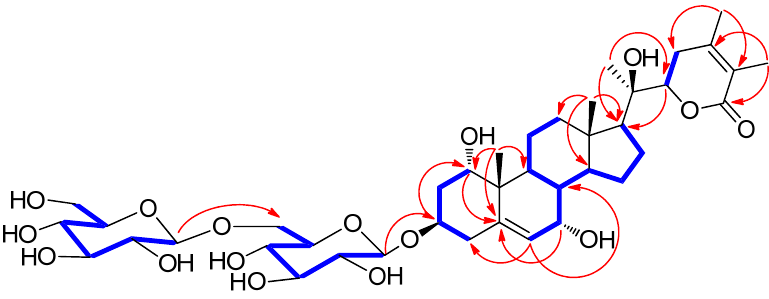
Figure 3. Key 1 H- 1 H COSY ( ) and HMBC ( ) correlations for 1 .